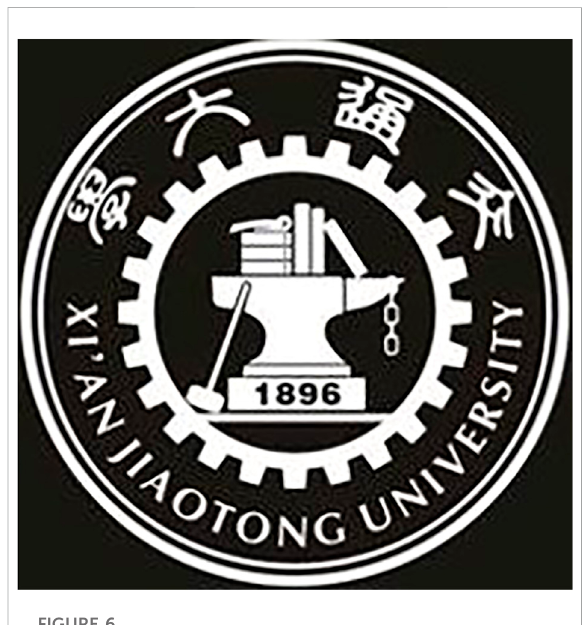
FIGURE 6 Original picture of the school badge for edge detection.